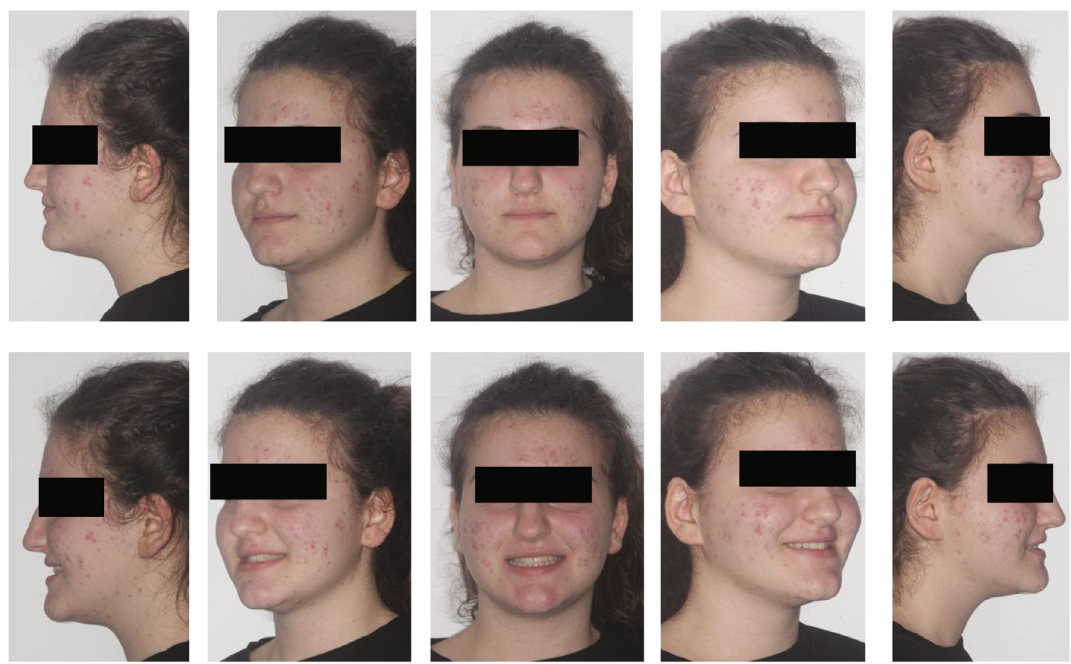
Figure 3: Initial extraoral